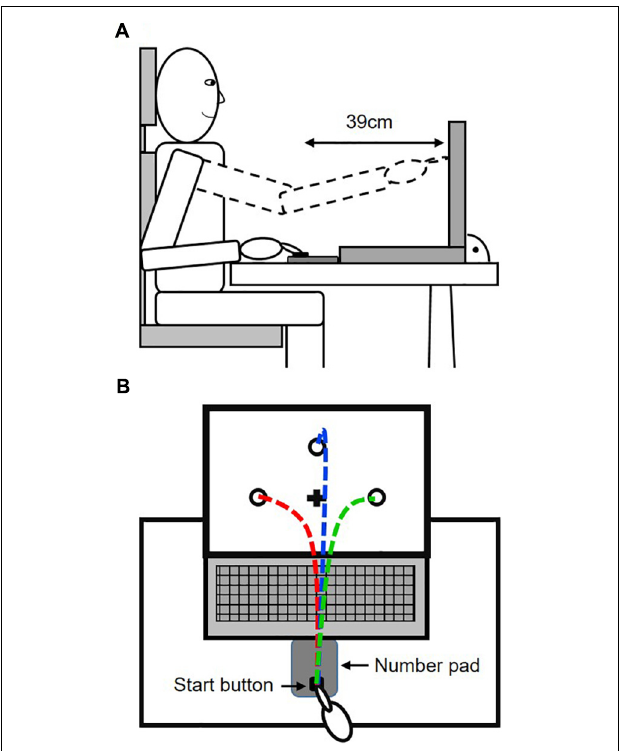
FIGURE 1 | Experimental set-up. (A) Side view on the set-up, depicting the reach distance and sitting position of the participants. (B) Top view, showing the principal configuration of potential target locations, fixation cross and potential reach